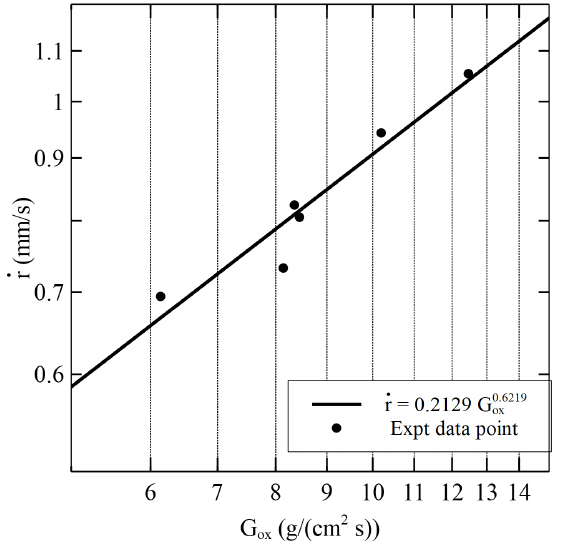
Figure 9. Burn rate versus oxidizer flux obtained from open loop